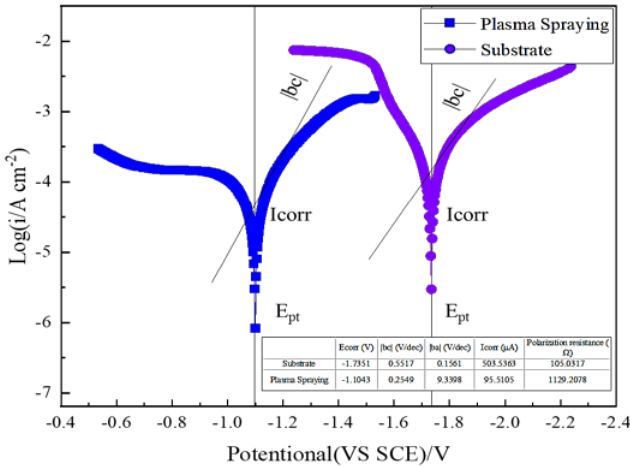
Figure 4. Tafel curves of the substrate and ceramic layer of VW75 magnesium alloy.